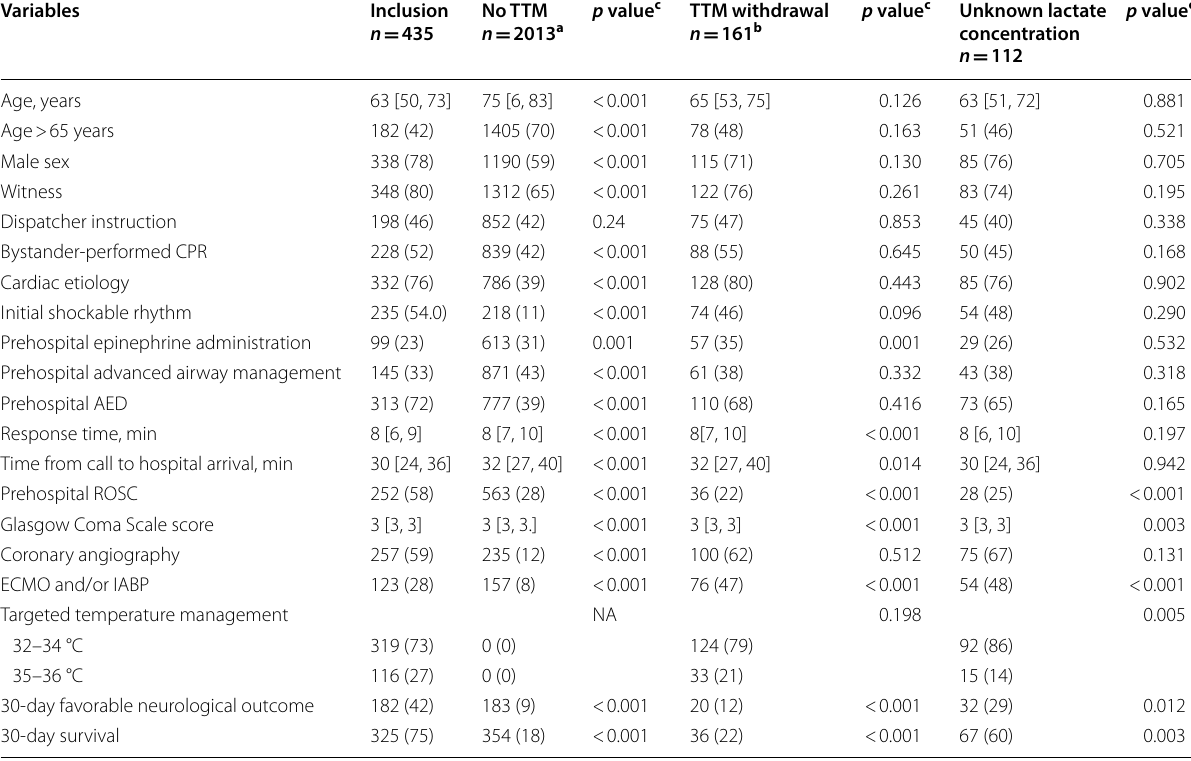
Table 1 Patient baseline characteristics between inclusion group and three exclusion